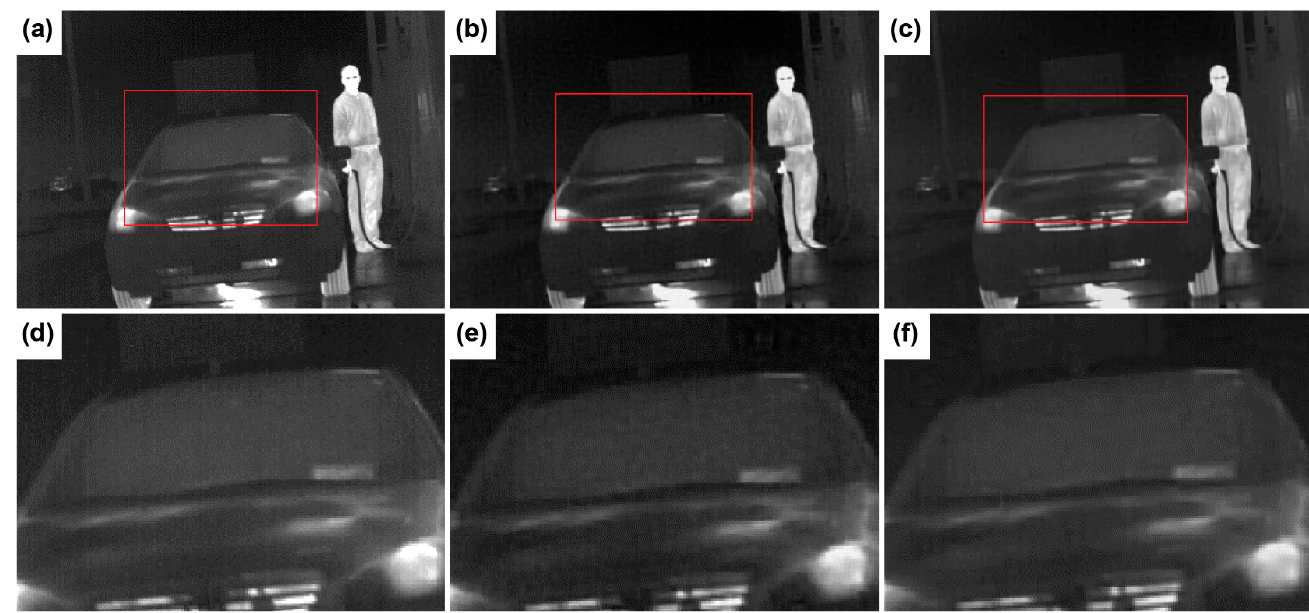
Figure 5. A comparison of deblurring effects of the two models on a station image. ( a ) The original station image, ( b ) the image deblurred using Lp_LOGS, and ( c ) the image deblurred using Lp_HOGS. ( d – f ) The Local enlarged images from the red boxes in ( a – c ), respectively.